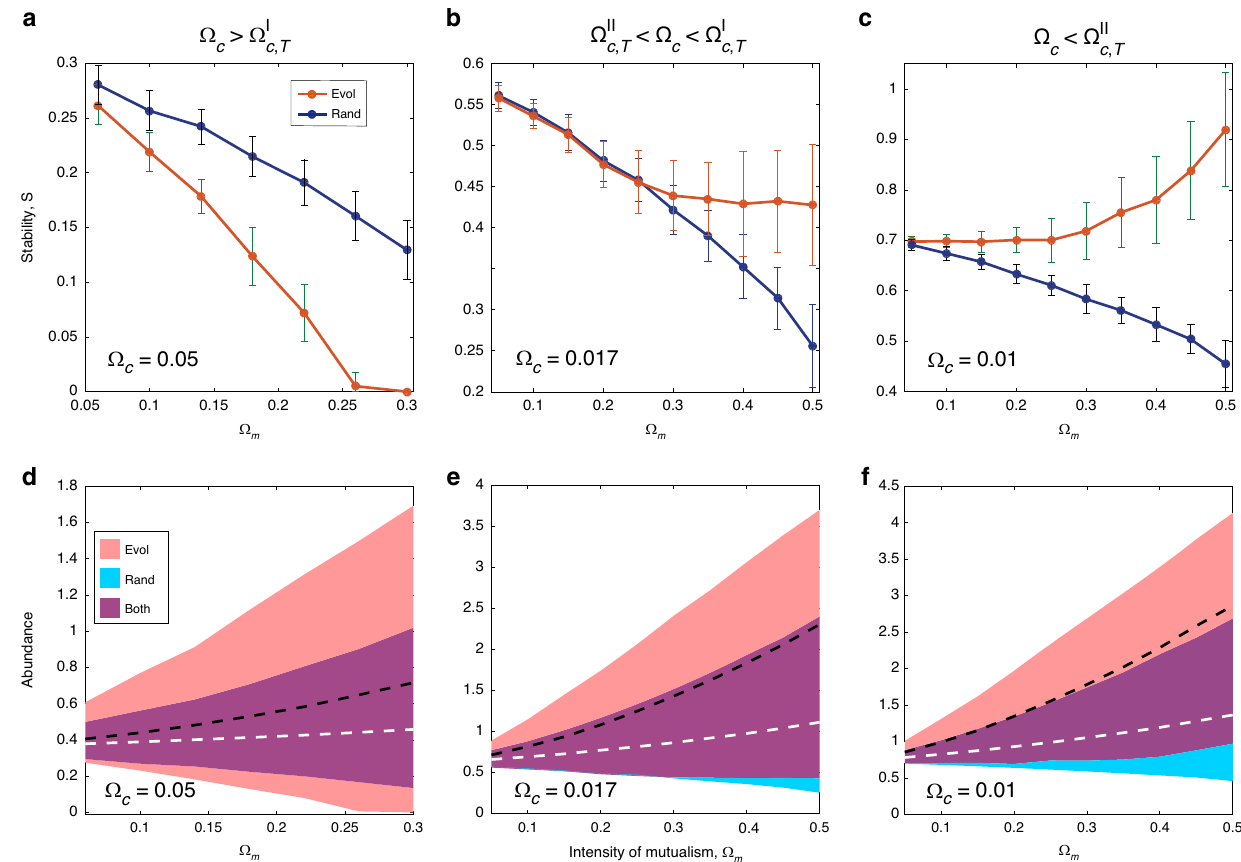
Fig. 3 Stability of assembled network. a – c Transitions of stability induced by competition intensity. The relative stability is persistently negative or positive compared with the randomized network for the competition intensity Ω c above or below the fi rst threshold Ω I c ; T (cid:1) 0 : 025 (between a and b ). At the second threshold Ω II c ; T (cid:1) 0 : 015, the regimes of competition intensity are separated where enhancing mutualism by Ω m would stabilize or destabilize the network (between b and c) . The scenarios are shown for typical values at Ω c = 0.05, 0.017, and 0.01 in the three intervals. The stability measures of the null model are shown by blue curves. Data are obtained from 50 simulation runs and presented as mean values± SD. d – f Demographic distributions. The network stability is associated with the lower bound of the population of all species. The relative position of the population distributions of the assembled network (red area) to the random counterpart (blue area) changes with the competition intensity, which reverses the relative stability (compare d and e ). On the other hand, enhancing mutualism is detrimental to the low-populated species at a relatively high competition level ( e ). Only at a suf fi ciently low competition level, the entire population and the stability rises with Ω m ( f ). The average population per species 〈 n 〉 is marked by black and white dashed lines for the assembled and random network,